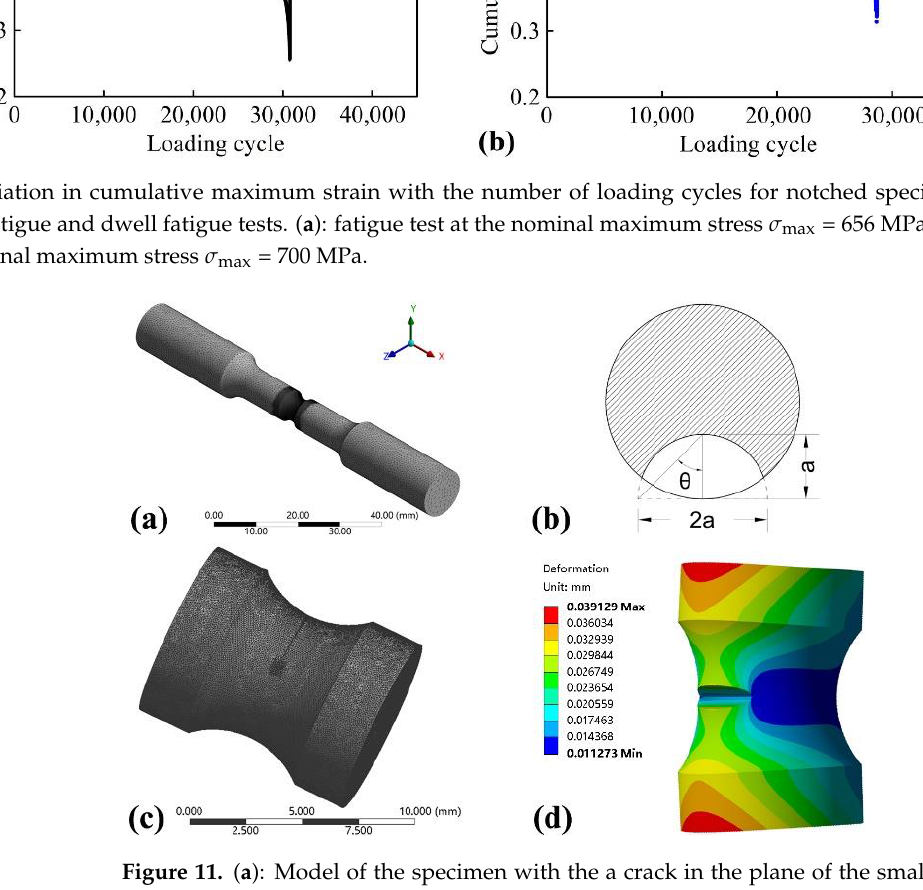
Figure 11. ( a ): Model of the specimen with the a crack in the plane of the smallest section of the specimen; ( b ): Sketch map of the semi-elliptical shape crack in (a); ( c ): Enlarged view of the 10 mm